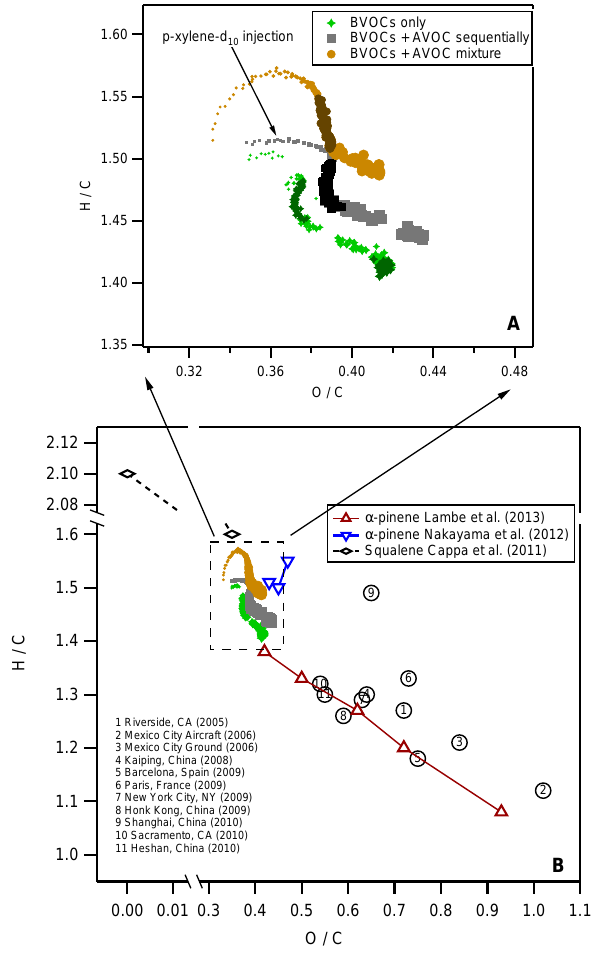
Figure 5. Van Krevelen diagram showing the ratio of H/C to O/C measured for the three experiments performed in this study: a mix- ture of α -pinene with limonene (green diamonds); a mixture of α -pinene with limonene with a sequential addition of p -xylene- d 10 (grey squares); and a mixture of α -pinene, limonene, and p - xylene-d 10 (orange circles). The change in marker size depicts time; smaller markers refer to the beginning of the experiment, and larger markers to the end. The top panel (A) shows specifically the three experiments performed in this study. The darker colors depict night- time. In the lower panel (B) , the results are compared to the low- volatility oxygenated organic aerosol factors from HR-AMS field campaigns (numbered circles, adopted from Daumit et al., 2013), results for α -pinene SOA from Lambe et al. (2013) (red triangles), and Nakayama et al. (2012) (blue inverted triangles), and squalene SOA from Cappa et al. (2011) (black